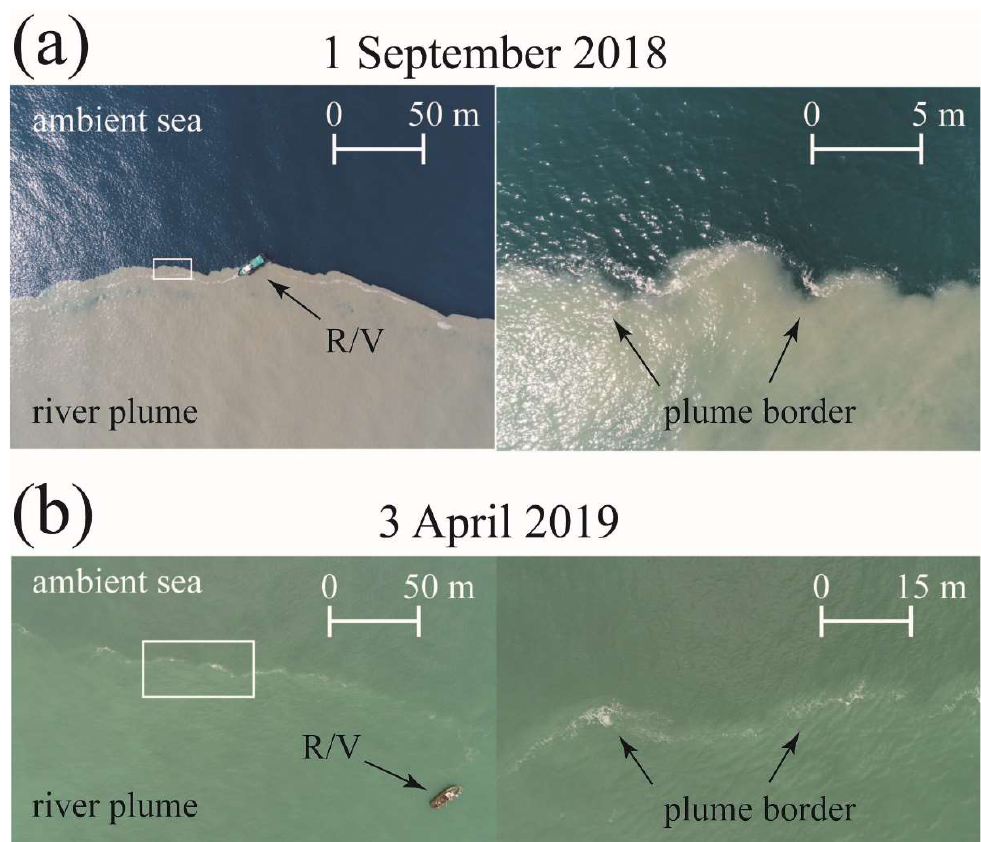
Figure 2. Aerial images of the Kodor plume border on: ( a ) 1 September 2018 and ( b ) 3 April 2019 illustrating different spatial scales of frontal instabilities. White boxes in the left panels indicate zoomed areas shown in right panels.